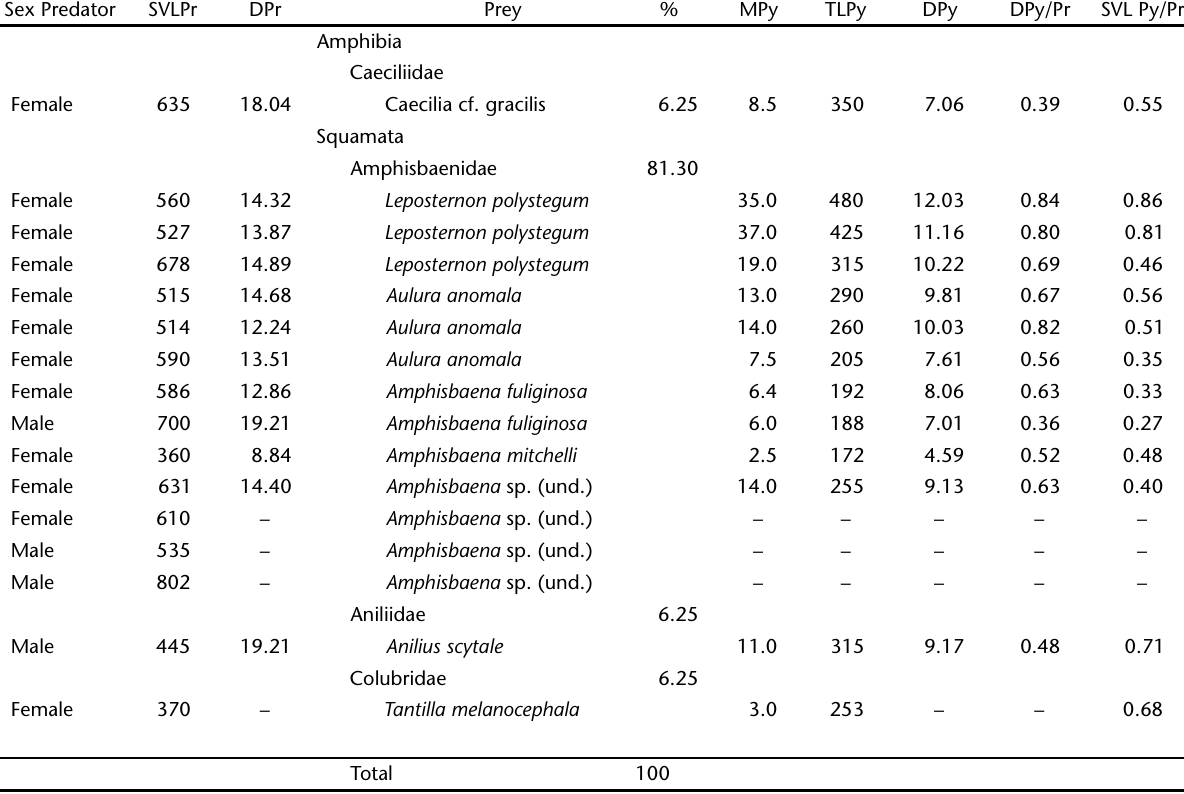
Table I. Preys and their frequency in the diet of 16 specimens of A. scytale , in Brazilian Amazon. (SVLPr) snout-vent length of predator (mm), (DPr) diameter predator (millimeters), (%) the percentage which each group of prey items represents of the total number of food items analyzed, (MPy) weight of prey (g), (TLPy) total length of prey in millimeters, (DPy) diameter of prey (mm), (DPy/Pr) proportional diameter of prey in relation to diameter of predator, (SVLPy/Pr) proportion total length of prey in relation to snout-vent length of